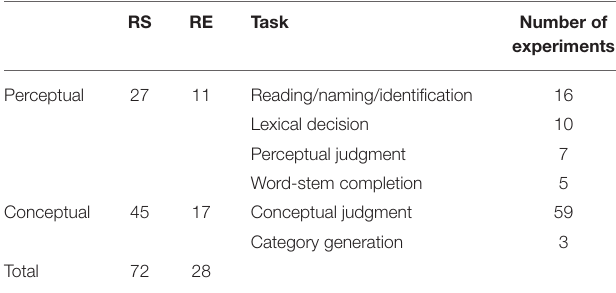
TABLE 1 | Number of experiments and included tasks in perceptual and conceptual